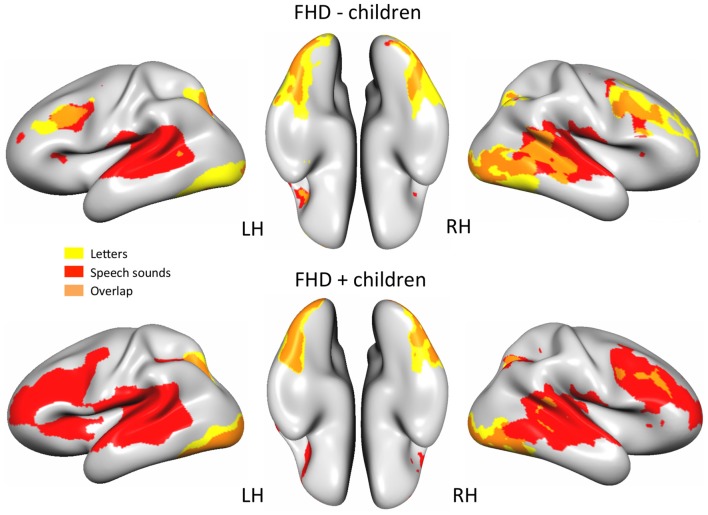
Brain areas involved in processing letters (yellow), speech sounds (red) or both unisensory conditions (orange) in children without (FHD−) and with (FHD+) family history of dyslexia (DYS; q(FDR) < 0.01).